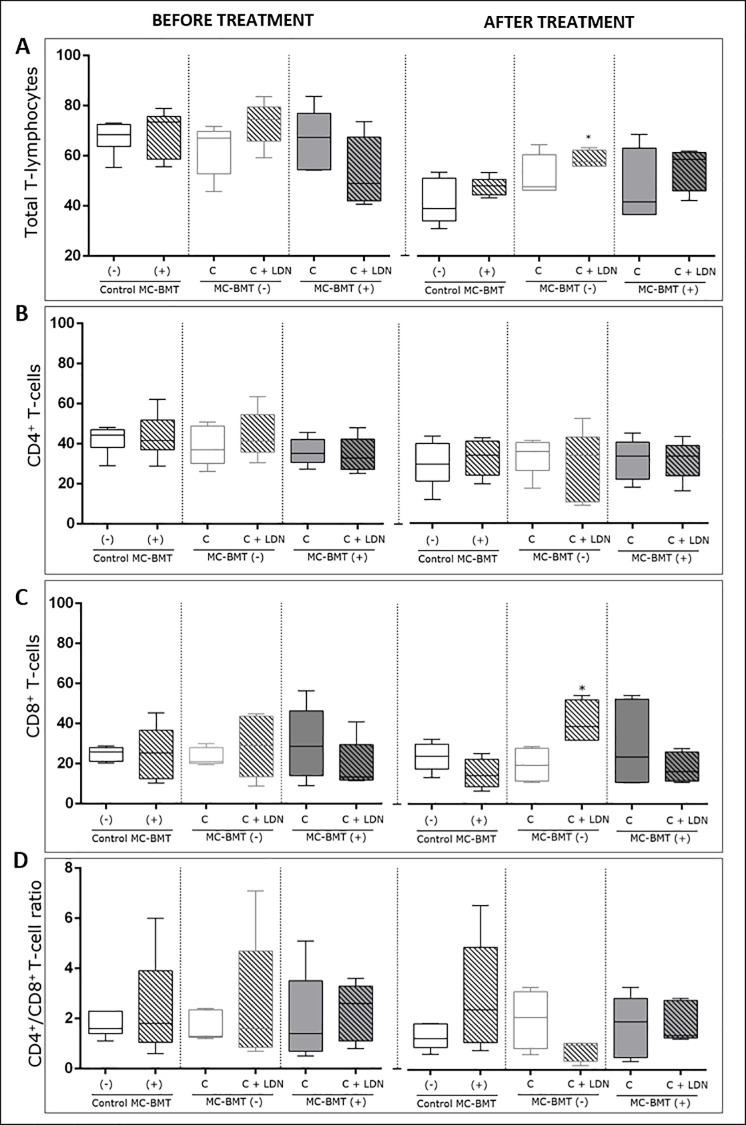
Flow cytometry immunophenotyping of total T-lymphocytes, CD4+ and CD8+ T-lymphocytes, and CD4+/CD8+ T-cell ratio in peripheral blood of female dogs with MC-BMT.Analysis is divided into before and after proposed treatment, subcategorized by the absence (-) or presence (+) of metastasis. Immunophenotypic analyses were performed using dual color flow cytometry as described in the Methods. Total lymphocytes were first selected based on their size (laser-forward scatter–FSC) and complexity (laser side scatter–SSC), and subsets were analyzed by quadrant statistics on FL1/FITC versus FL2/R-PE dot plots. Results are shown in a box plot format showing the minimum, median and maximum values of total T-lymphocytes. (A) CD4+ (B) and CD8+ T-lymphocytes (C) (expressed as a percentage of gated lymphocytes) and CD4+/CD8+ T-cell ratio (D) (expressed as a proportion). *Significant differences at p < 0.05, according to the Kruskal-Wallis test.